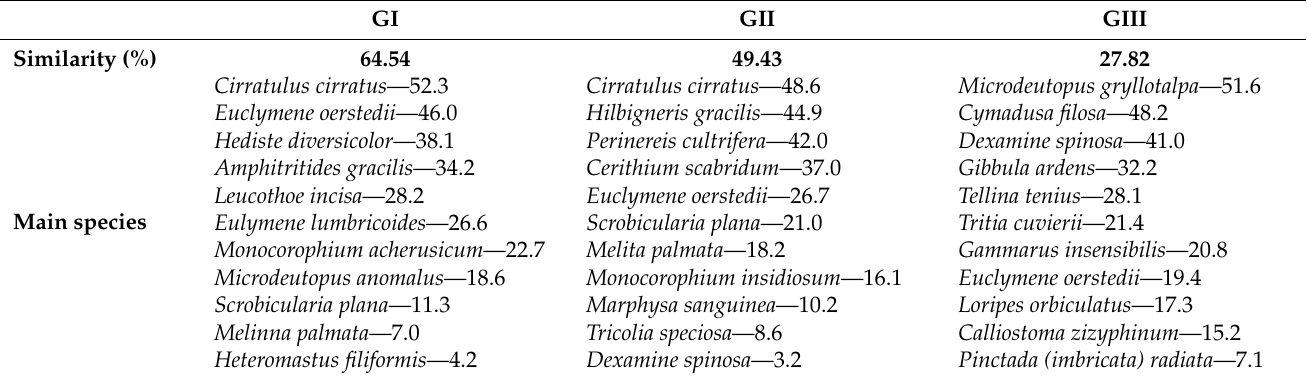
Table 4. Groups formed by n-MDS ordination, with indication of similarities between each group (%) and the most representative species (% of contribution for the similarity within the group) contributing to the similarity within the group, determined with SIMPER